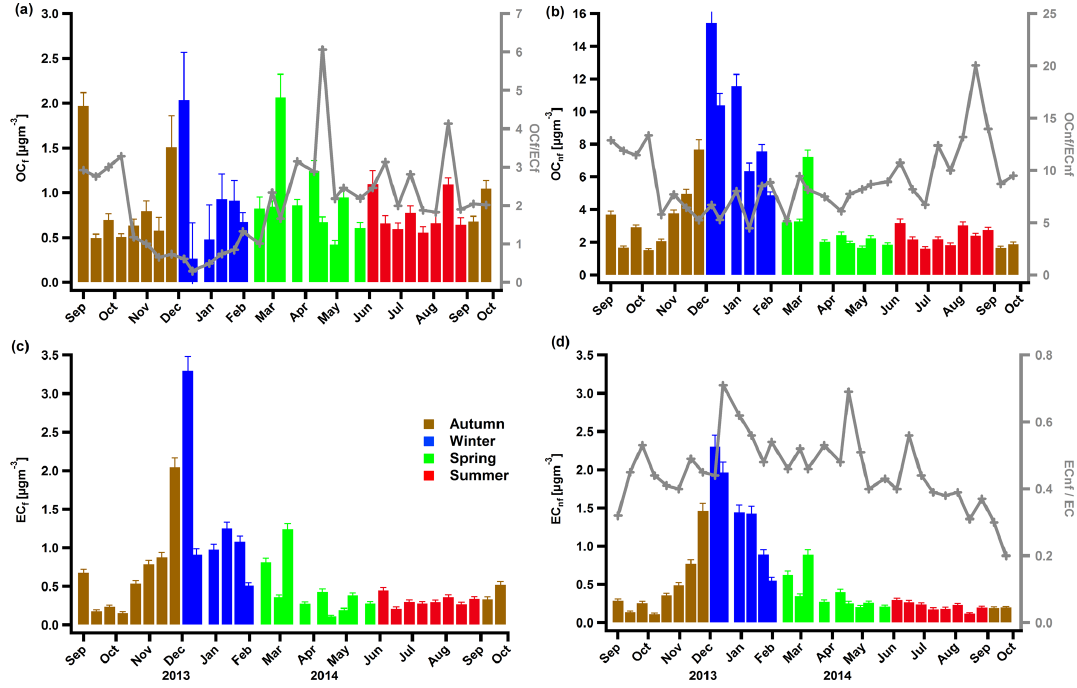
Figure 3. Concentrations in PM 10 of OC f (a) , OC nf (b) , EC f (c) and EC nf (d) colour-coded by seasons. The ratios OC f / EC f , OC nf / EC nf , and EC nf / EC are also displayed in (a) , (b) and (d) , respectively. Table 1. Median OC and EC non-fossil fractions per season in PM 10 with interquartile range. Autumn Winter Spring Summer Q 25 Q 50 Q 75 Q 25 Q 50 Q 75 Q 25 Q 50 Q 75 Q 25 Q 50 Q 75 f NF , OC 0.71 0.77 0.83 0.87 0.88 0.93 0.70 0.75 0.79 0.73 0.76 0.79 f NF , EC 0.36 0.41 0.44 0.44 0.52 0.56 0.42 0.49 0.51 0.38 0.39